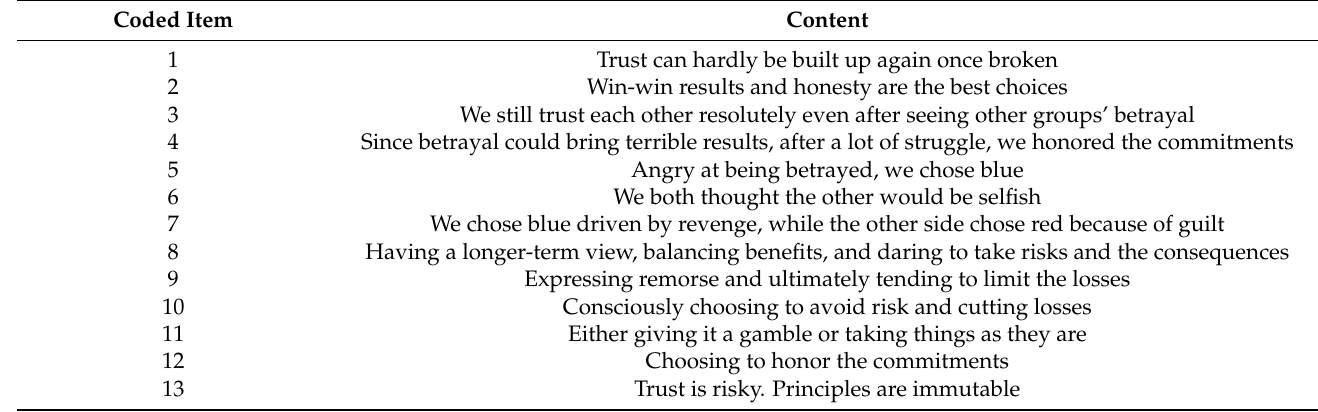
Table 2. Open-coded items of emotional regulation